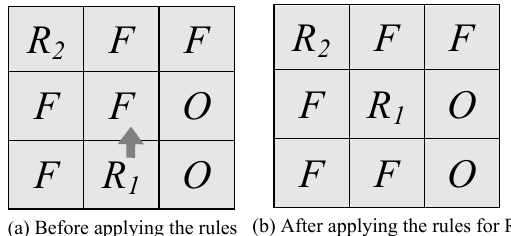
Fig. 4. The robots do not collide with each other in multi- robot problem